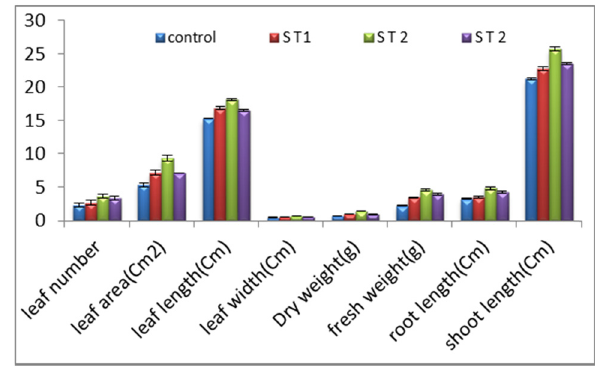
Figure 3: E ff ect of di ff erent concentrations ( 1%, 2%, 4% ) of SLE in growth parameters of T. aestivum